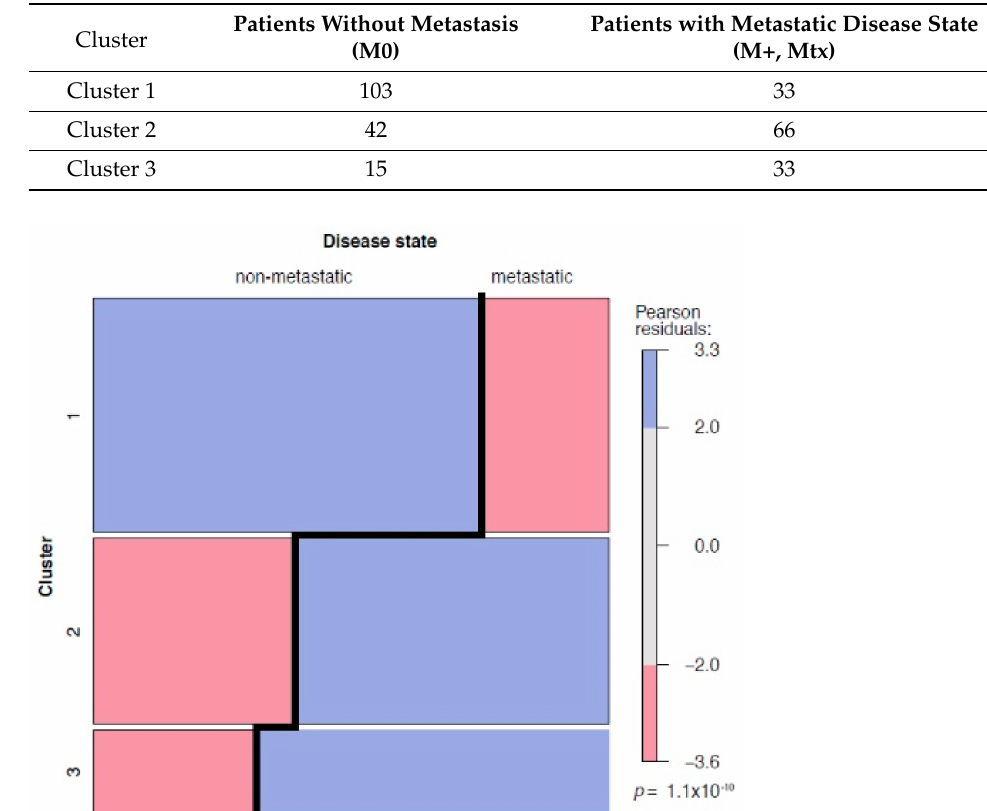
Figure 6. Left and right columns show the associations of clusters with either non-metastatic (left column, primary tumor M0 group) or metastatic disease state (right column, primary tumor M+ group and metastatic tissue Mtx group). Blue boxes indicate over-represented disease states in a cluster (Pearson residuals > 2), whereas red boxes correspond to under-represented disease states (Pearson residuals < − 2), providing statistical evidence that clustering is not independent from the metastatic disease state ( p = 1.1 × 10 − 10